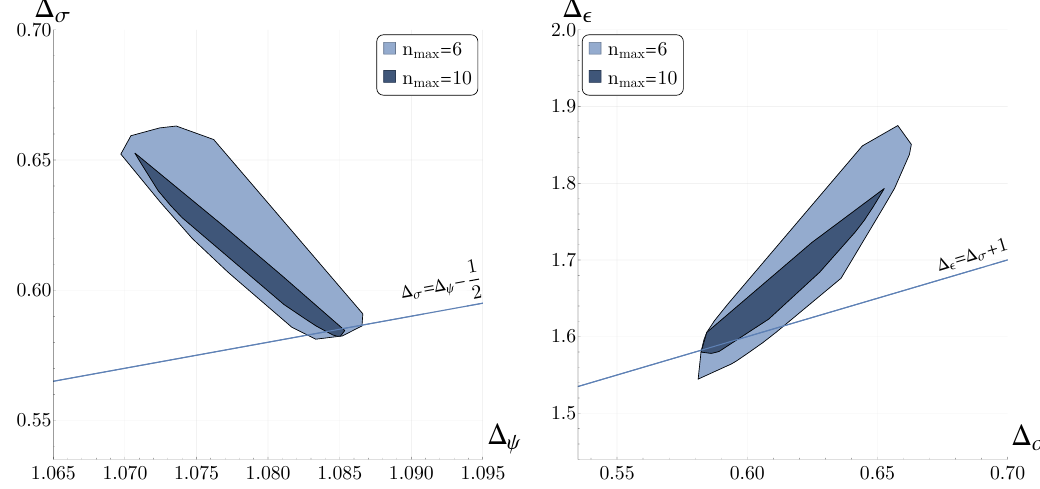
Figure 8 . The allowed region for the N = 1 critical GNY model when imposing that ∆ σ 0 > 2 . 5 , projected to the (∆ ∆ ) and (∆ ∆ ) planes. The solid lines capture the expected relation between ψ , σ σ , (cid:15) scaling dimensions in an N = 1 SCFT. The tip intersects with the supersymmetric constraint on scaling dimensions, though note that due to the projection and visualization method (described in section 3.4.2) that the extent of that intersection is exaggerated, as the line and island are actually in 3-dimensional space. We separately computed a binary search along the supersymmetric line in all three external dimensions and found a rigorous estimate of ∆ = 0 . 58444( 8 ) . This agrees σ 0 exactly with those found for the N = 1 super-Ising model in